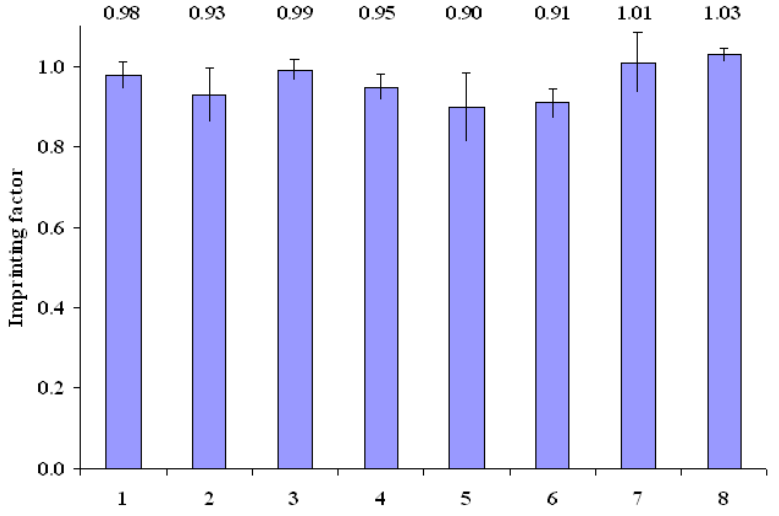
Figure 2 . Imprinting factors of evaluated pairs of polymers in aqueous